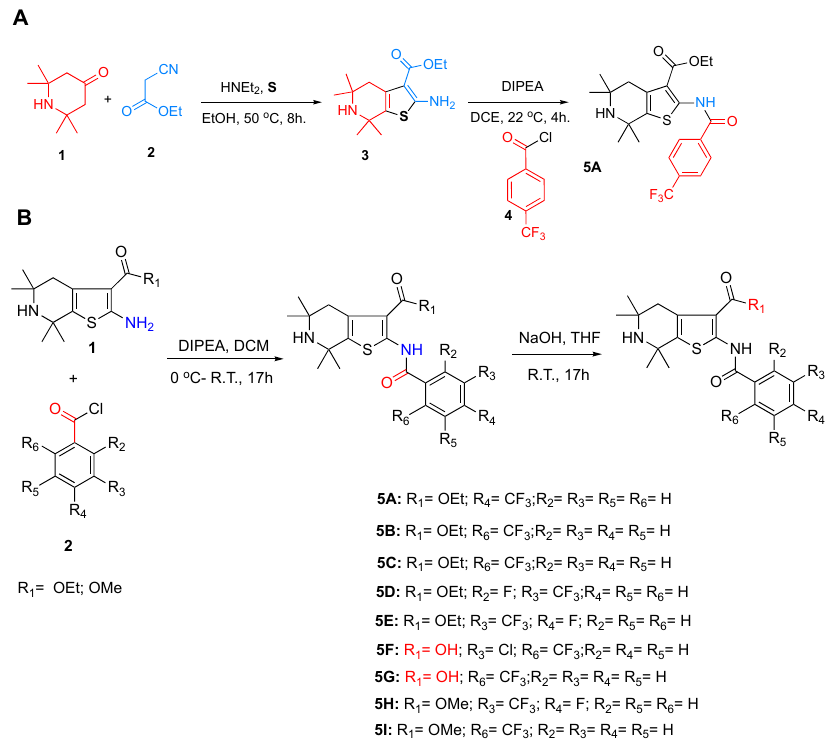
Figure 1. ( A ) Synthesis of thiophene 5A (Ethyl 5,5,7,7-tetramethyl-2-(4-(trifluoromethyl)benzamido)-4,5,6,7-tetrahydrothieno [2,3-c]pyridine-3-carboxylate). ( B ) Synthetic route for the creation of thiophene compounds.